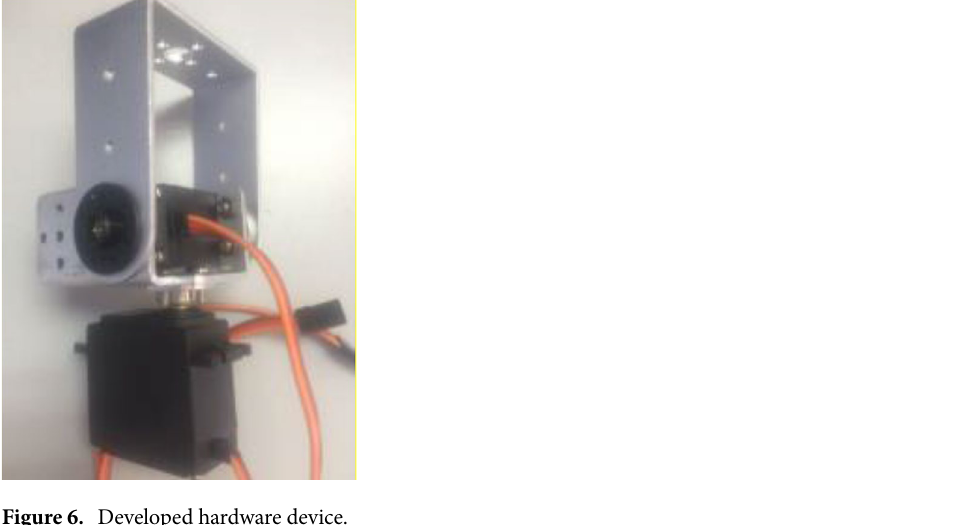
Figure 6. Developed hardware